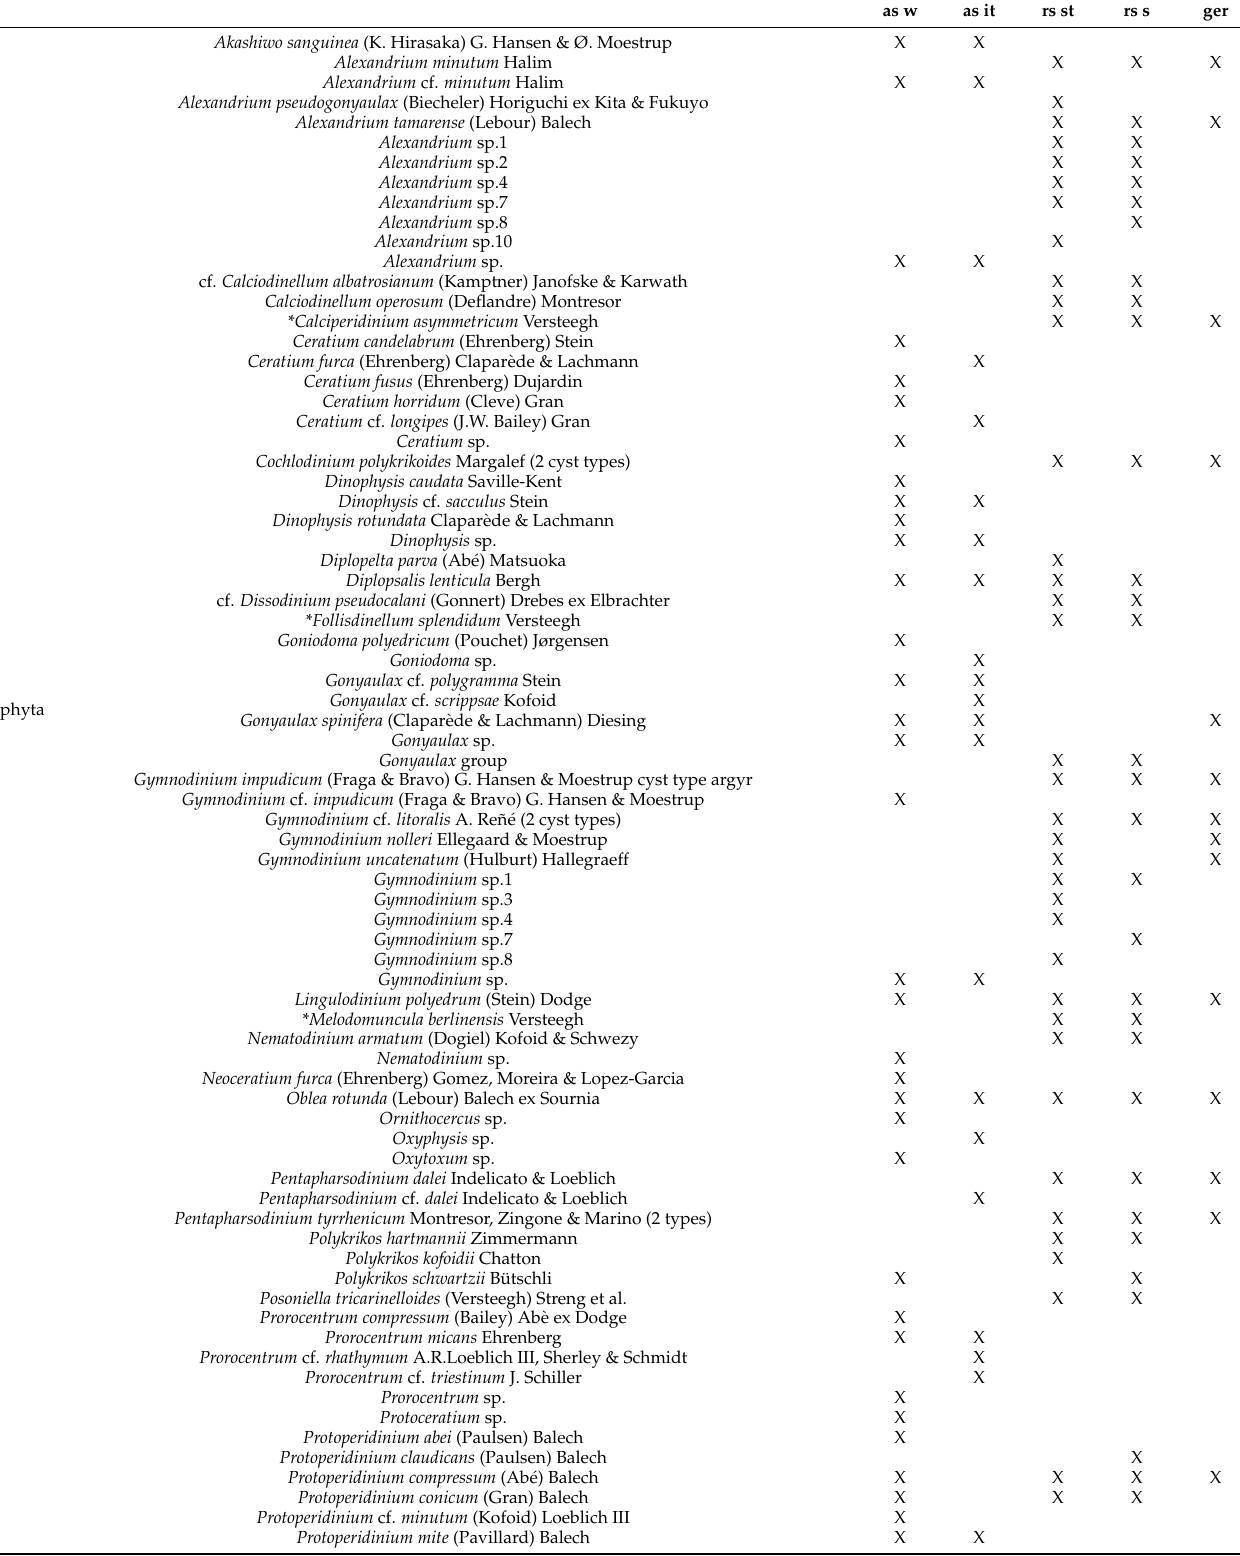
Table 3. List of the taxa recognized in the different sampling devices utilized in the study. The taxa registered with different life stages (e.g., nauplii and copepodites) were considered only once. as w : active stages in water column; as it : active stages in inverted traps; rs s : resting stages in the surface sediments; rs st : resting stages in the sediment traps; ger : germination achieved. * paleontological